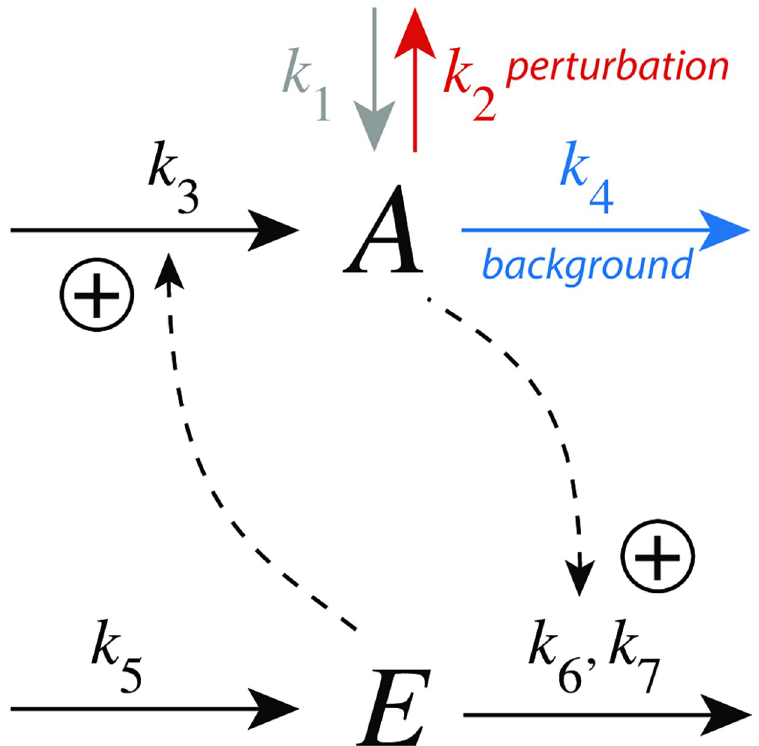
Fig 3. Inflow controller m1 with integral control implemented as a zero-order Michaelis-Menten (MM) type removal of E . k 2 undergoes a step perturbation, k 3 is a rate constant for the inflow of A , while k 4 is a constant background reaction. k 6 and k 7 are MM parameters analogous to V max and K M , respectively. In the calculations the grayed-out rate constant k 1 will be set to zero.